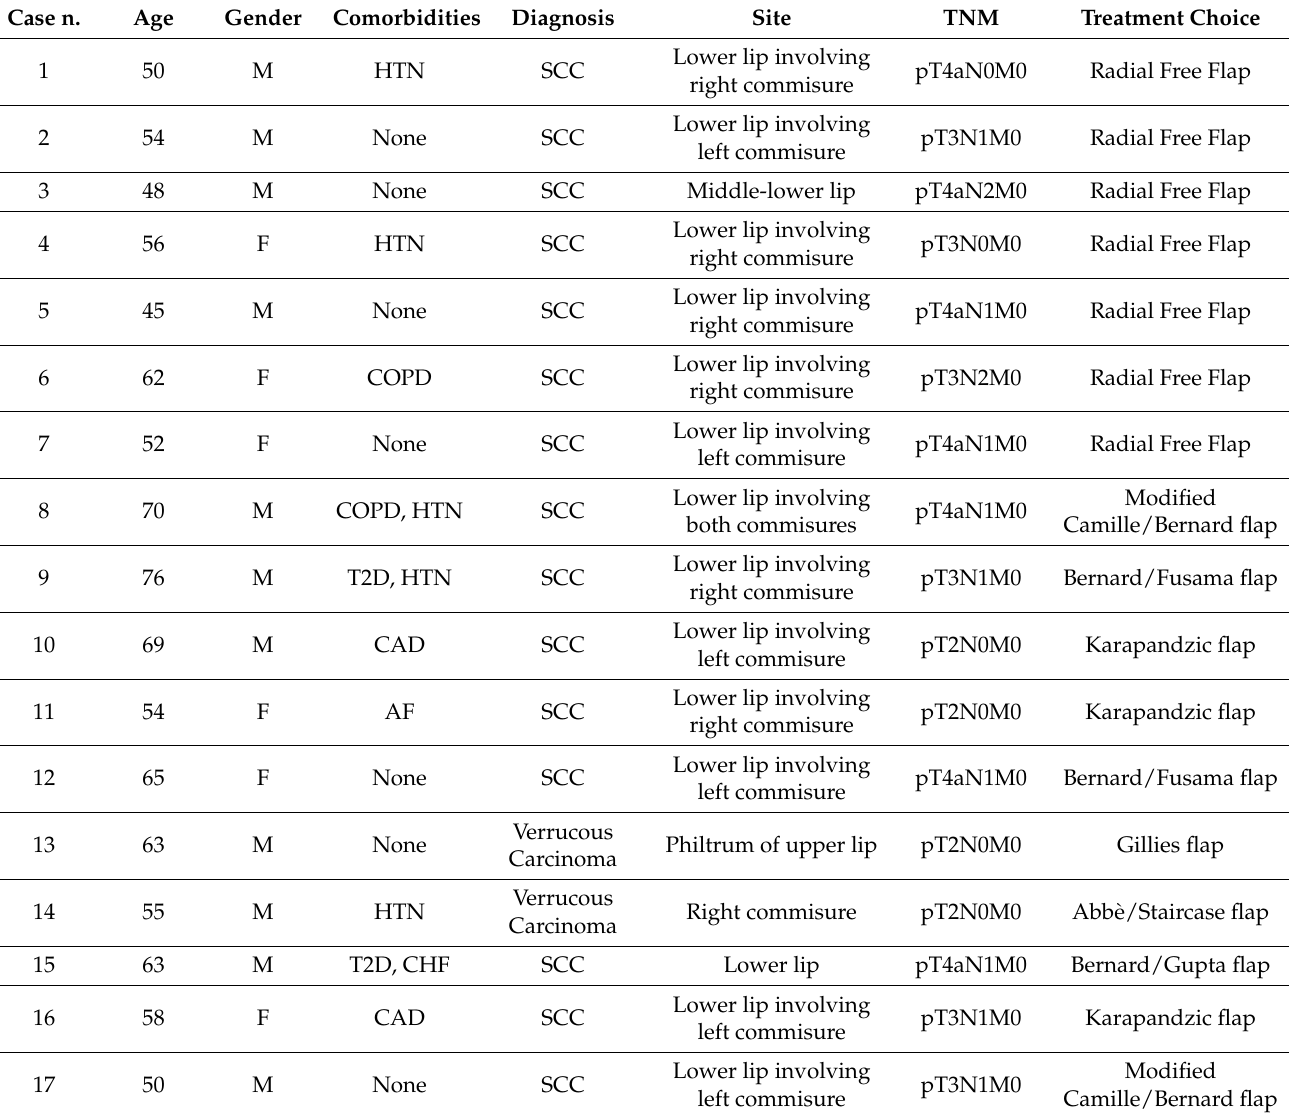
Table 1. Patients’ epidemiology and reconstructive strategies. HTN = hypertension; COPD = chronic obstructive pulmonary disease; T2D = type 2 diabetes; AF = atrial fibrillation; CHF = congestive heart failure; CAD = coronary artery disease; SCC = squamous cell